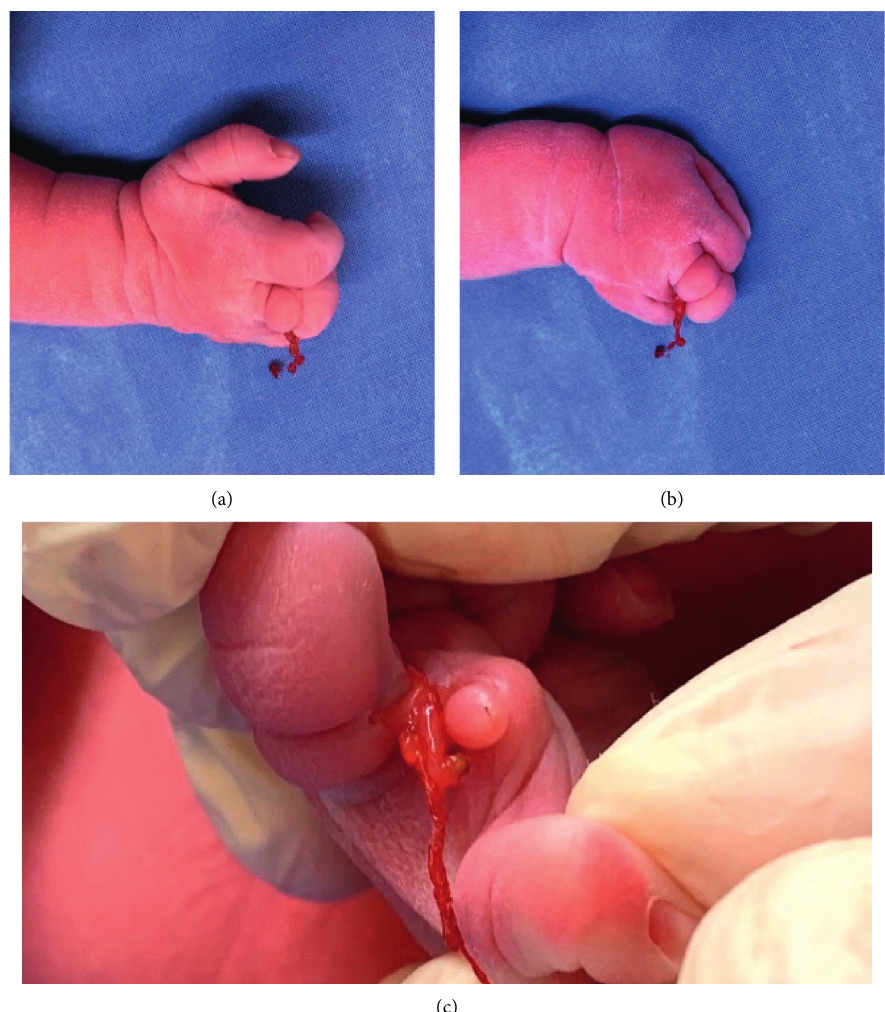
Figure 2: Right hand. Annular furrows on the third finger (a); spontaneous amputation of the fourth finger (b); the amputated finger